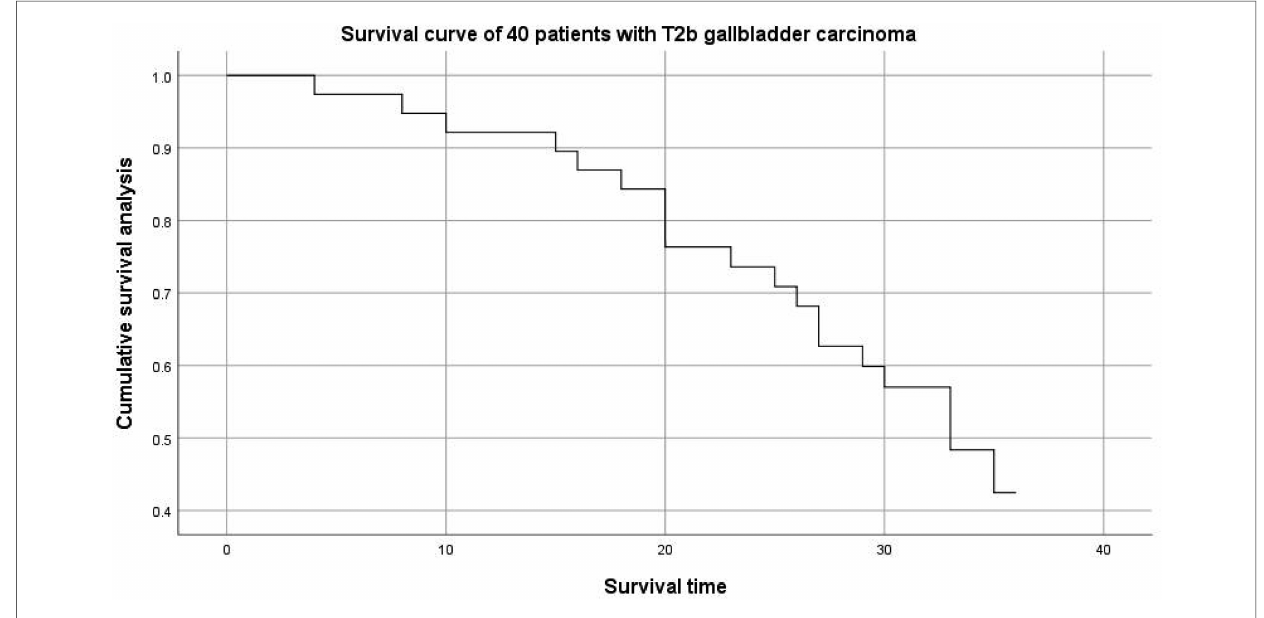
FIGURE 1 Survival curve of 40 patients with T2b gallbladder